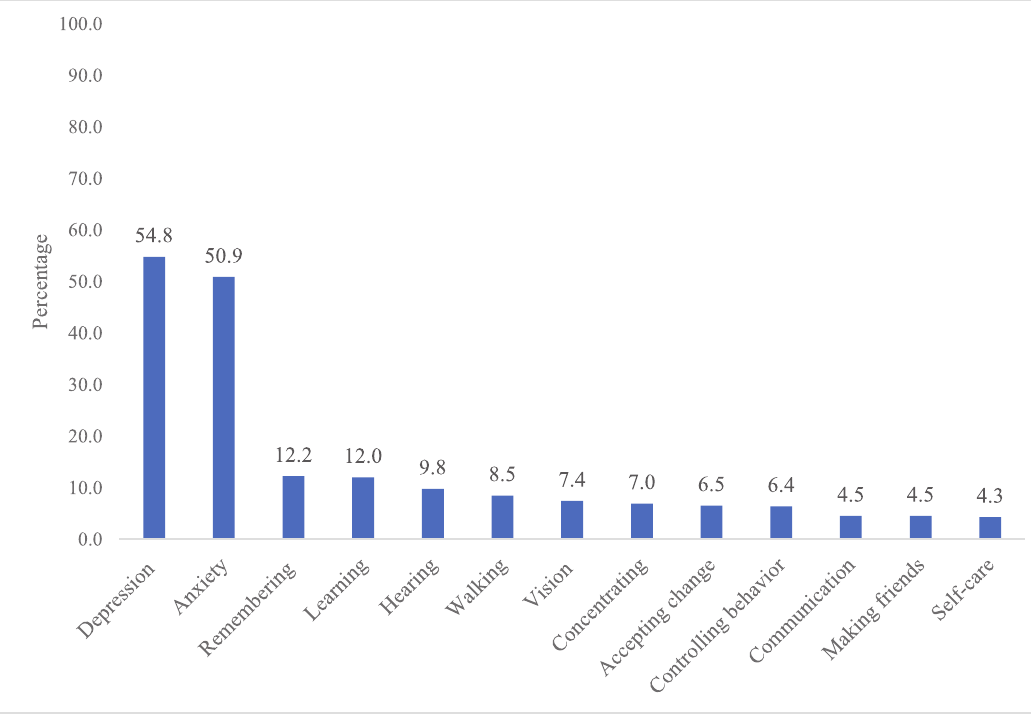
Fig 2. Percentage distribution of overall disability by CFM domains (n =